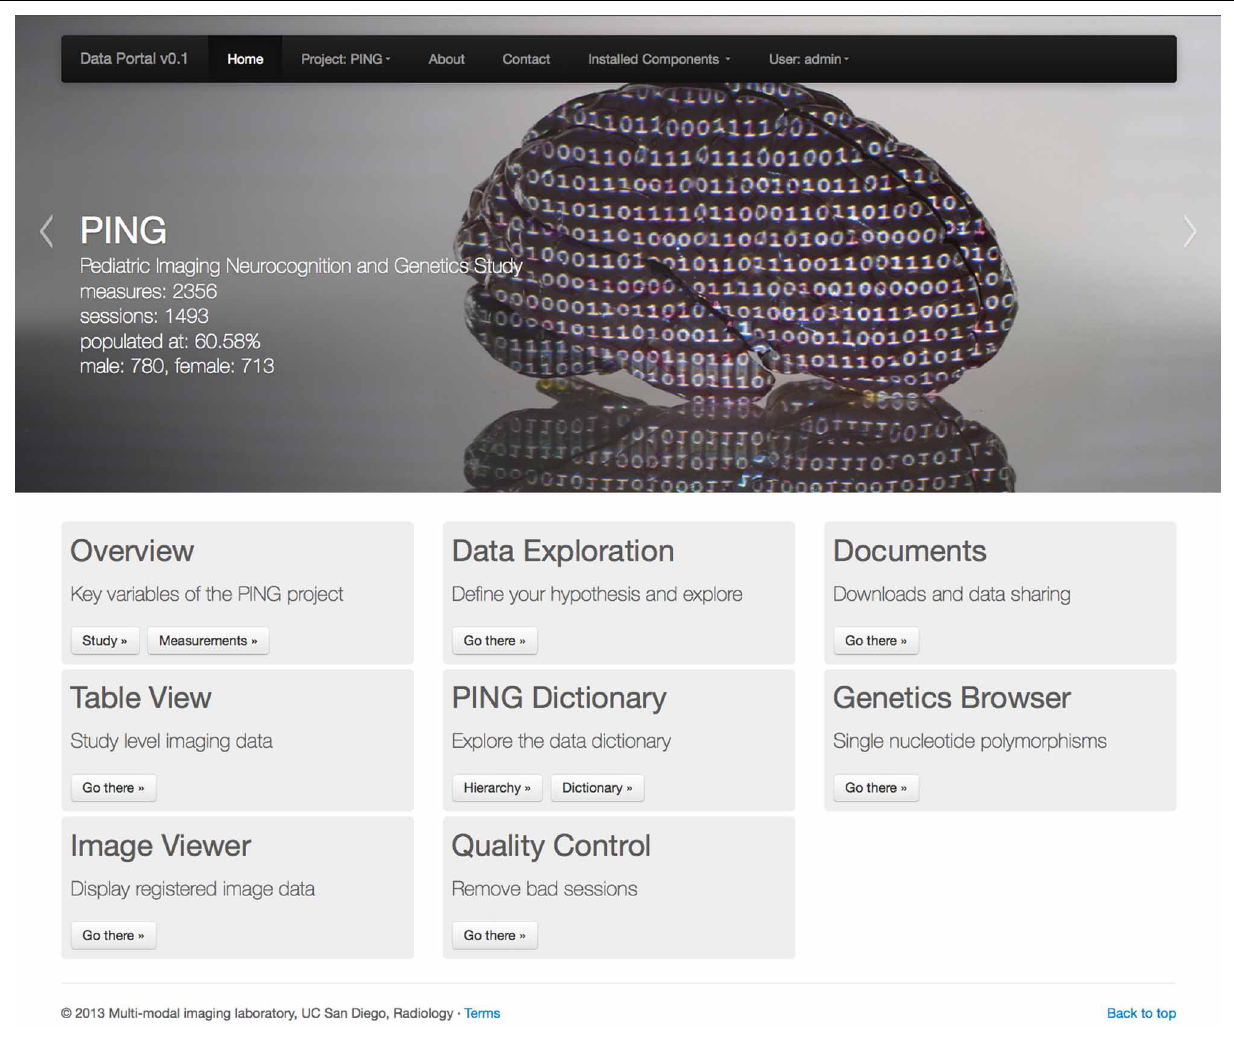
displayed in the top half of the page followed by a list of eight application groups. See section 2 for a description of each